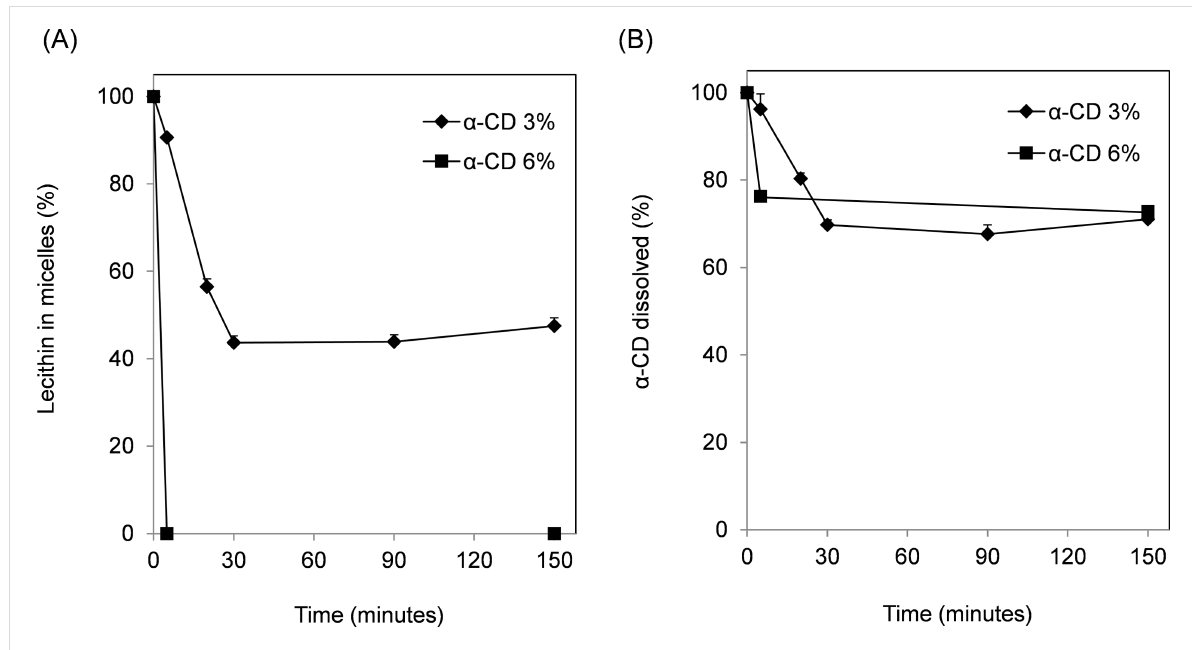
Figure 4: Time-dependent relationship between decreases in lecithin and α -CD. The experimental conditions were the same as those described in the legend to Figure 2, except for shaking time. Lecithin (A) and α -CD (B) contents in the filtrate were measured. α -CD in micelles (%) given as dissolved α -CD content compared with additional α -CD content. Means and standard errors are indicated ( n = 3).